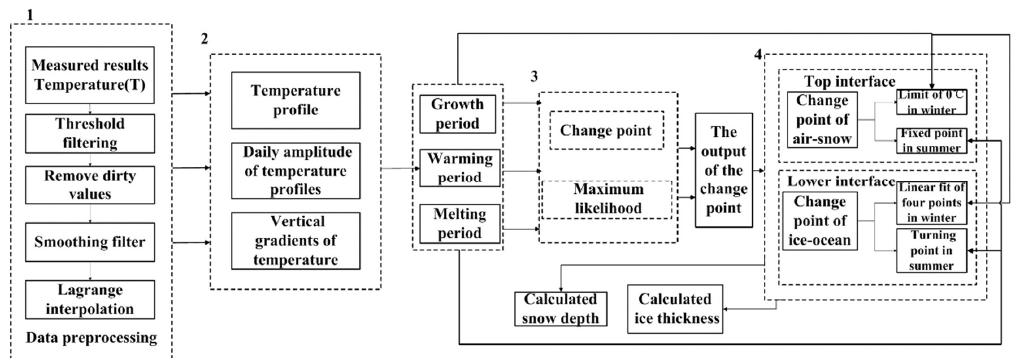
Figure 14. Schematic of the procedure for snow depth and ice thickness calculation during any period of ice season (ice growth, ice warming and ice melting) and deployment position (Arctic or Antarctica) by ice-tethered buoys. The bold numbers indicate major step in this approach, as noted in the paper. The procedure to determine snow depth and ice thickness using the morphological temperature profile (linear or C–type) was according to the discussed determination modes. Information of ice season (growth period, warming period and melting period) were also considered. The top and lower interfaces were represented by change points to calculate snow depth and ice